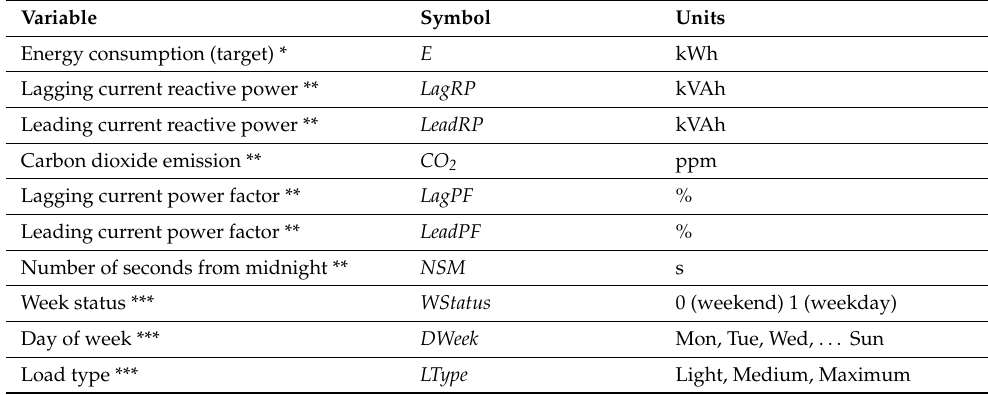
Table 3. Predictors of energy consumption in a steel plant (Sathishkumar et al. [24]). Variable Symbol